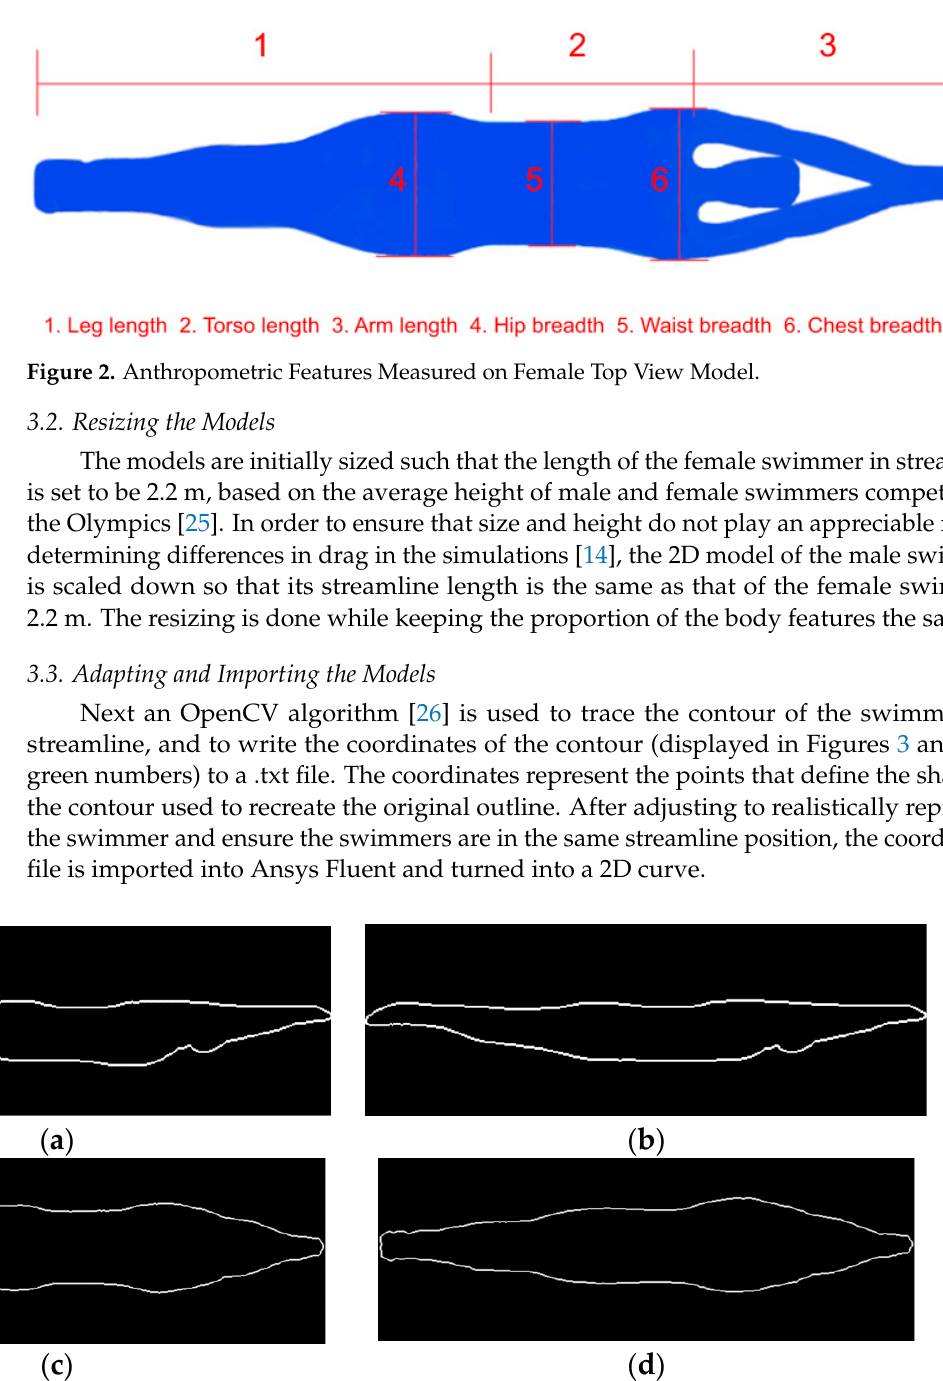
Figure 2. Anthropometric Features Measured on Female Top View Model. Table 1. Average Human Anthropometric Proportions (Percentage of Total Streamline Length) (From [23,24]).